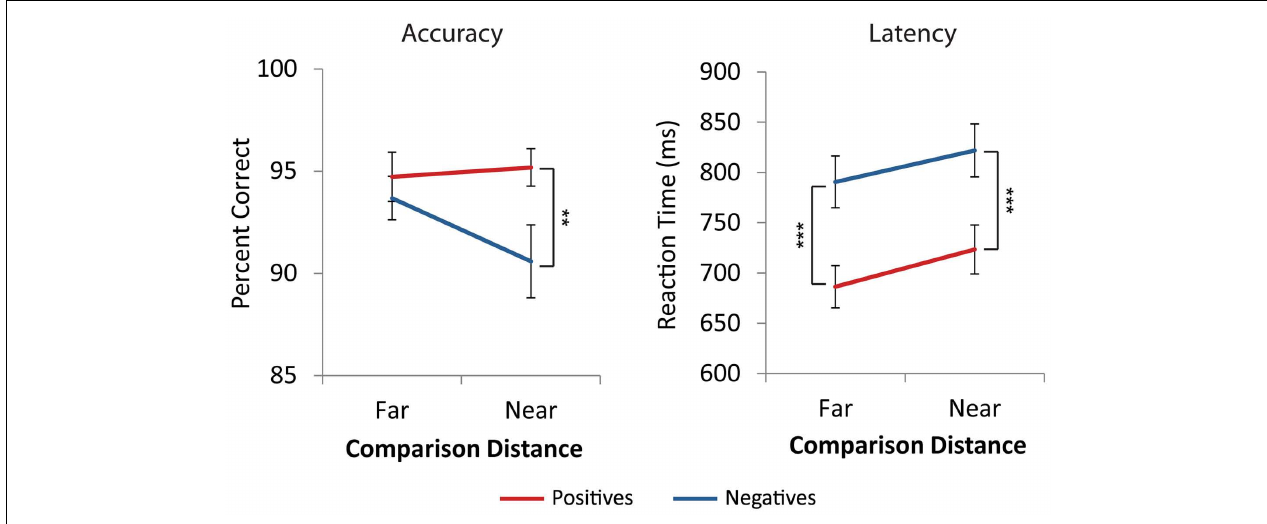
FIGURE 2 | Behavioral performance. Participants were less accurate on near comparisons with negative numbers than positive numbers (** p < 0.01), but did not differ on far comparisons. Participants were slower on negative problems than positive problems for both near and far comparisons (*** p < 0.001). Error bars represent ± 1